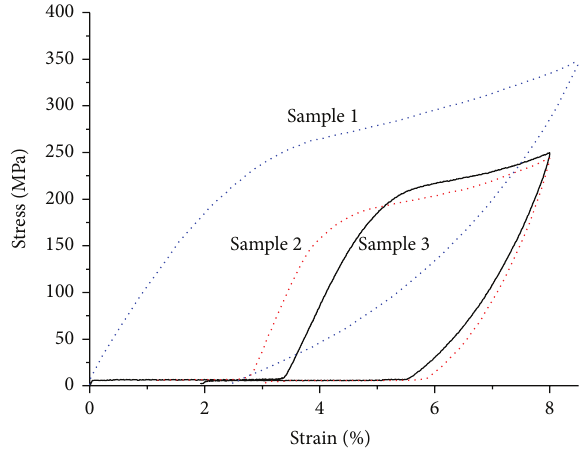
Figure 11: Stress-strain cycles with 𝜀 𝑡 of about 8% for different heat